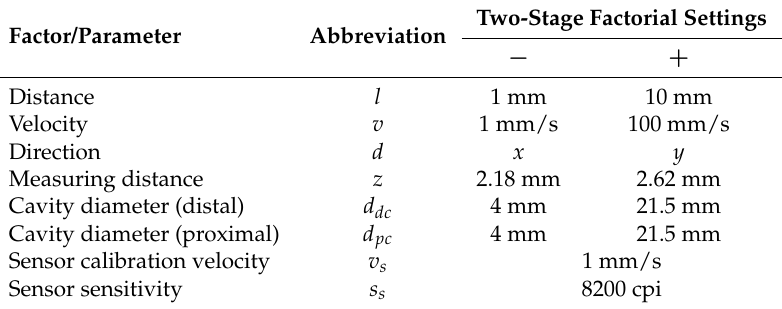
Table 2. Values of two-stage fractional factorial screening test factors and parameters for trial session two.